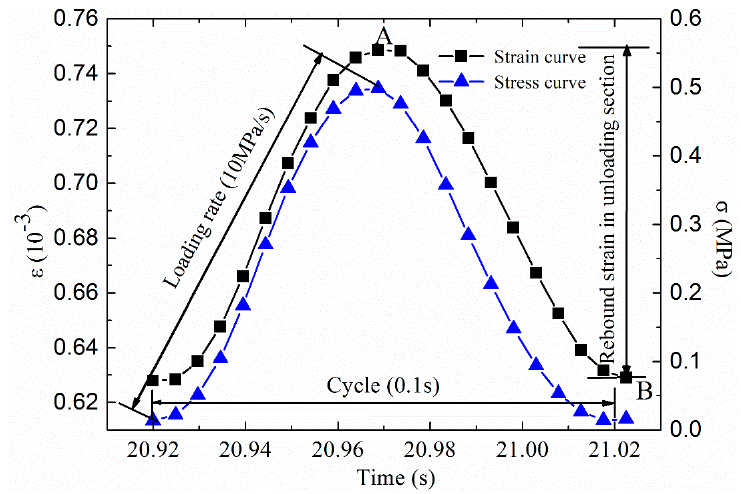
Figure 3. The curves of stress and strain with time.